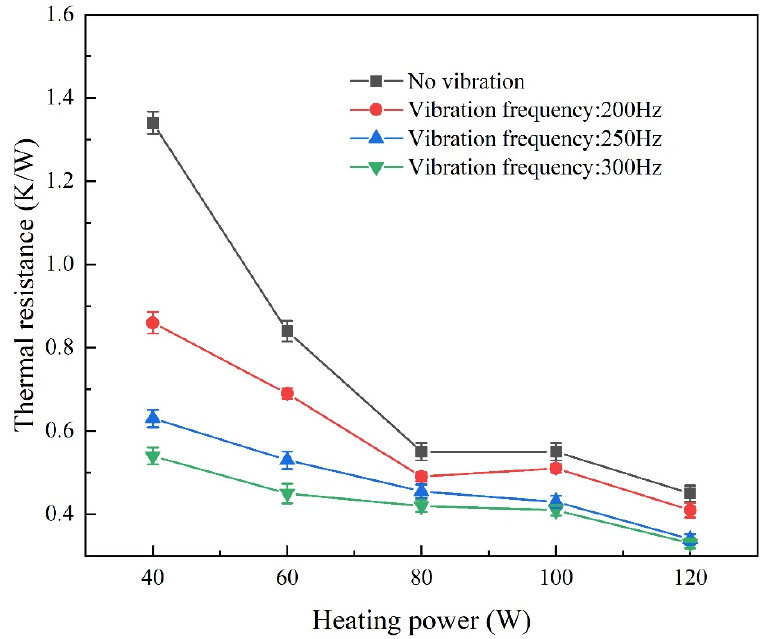
Figure 9. Influence of vibration frequency on the thermal resistance of the PHP under different heat- ing power levels (vibration on the evaporation section).